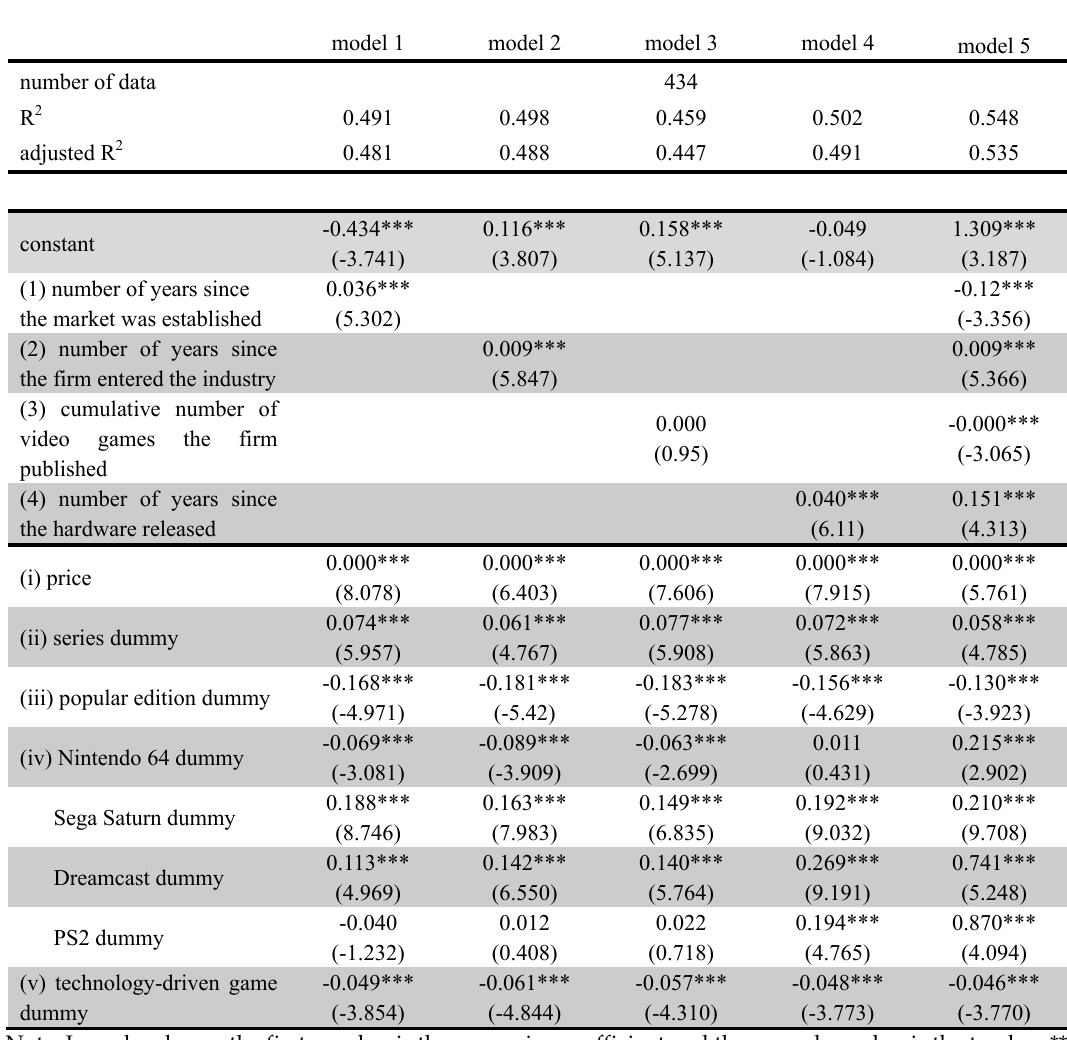
Table 2. Results by multiple regression